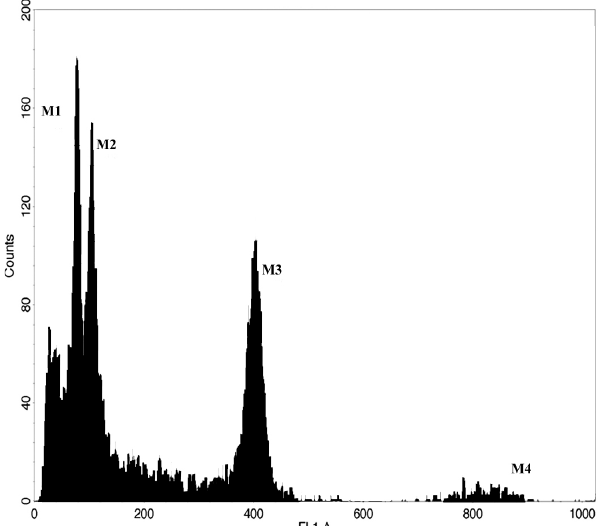
Figure 1. Flow Cytometry DNA content histogram. Flow cytometry analysis of DNA fluorescence peaks (FL1A) from G0/G (2C) PI stained leaf nuclei from cultivated cardoon (M1), globe artichoke (M2) and 1 P. sativum (pea) (M3). Pea was used as an internal standard and the peak was set at channel 400; M4 shows pea G nuclei (4C). 2 Table 1. Morphometric analysis of C. cardunculus chromosomes. Morphological analysis of the 2n = 34 chromosomes of cultivated cardoon ( A ) and globe artichoke ( B ) based on Fig. 3A, B, respectively.